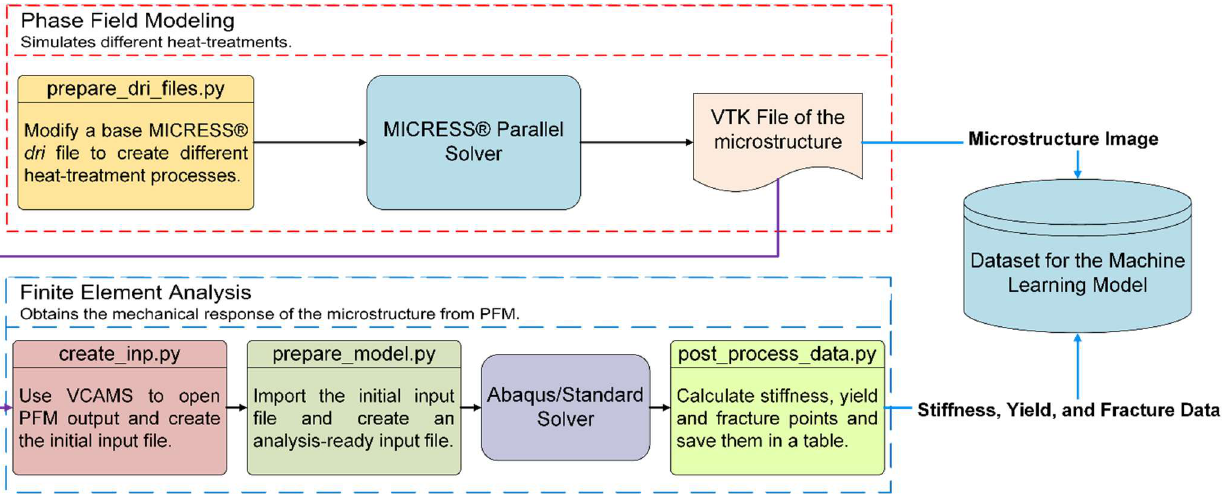
Figure 1. Workflow of the microstructure data generation with different heat treatment conditions.